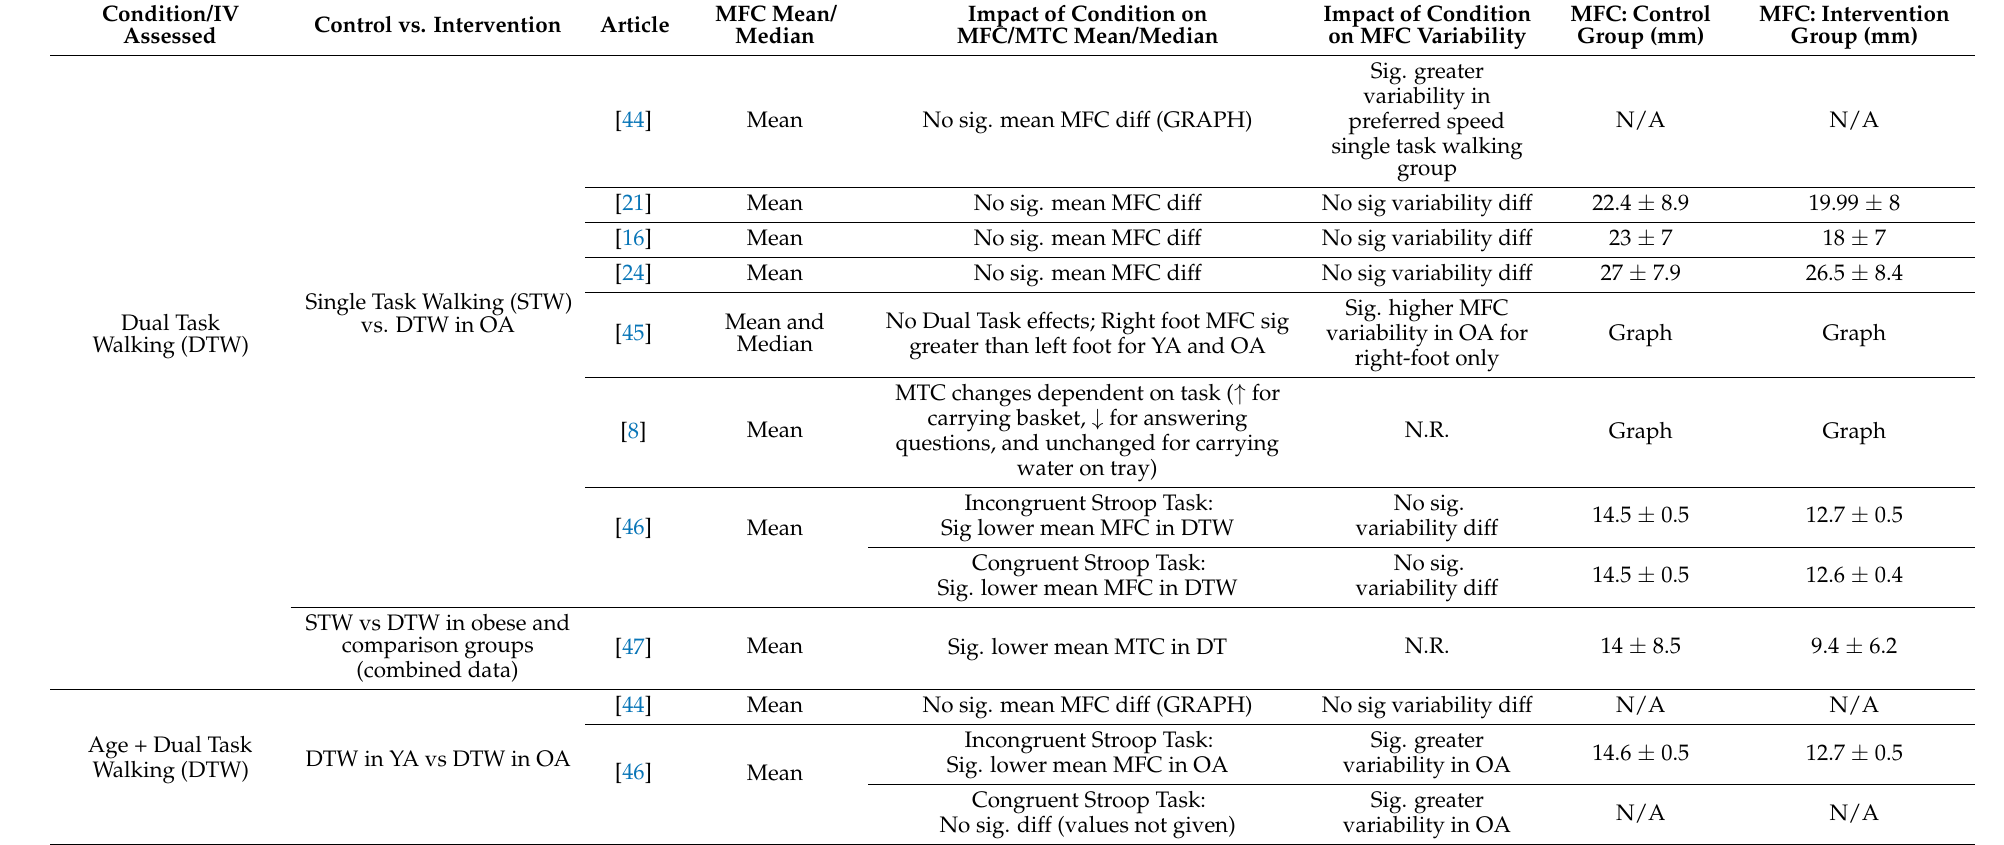
Table 4. Summary of findings in included papers for conditions that decrease mean or median MFC relative to